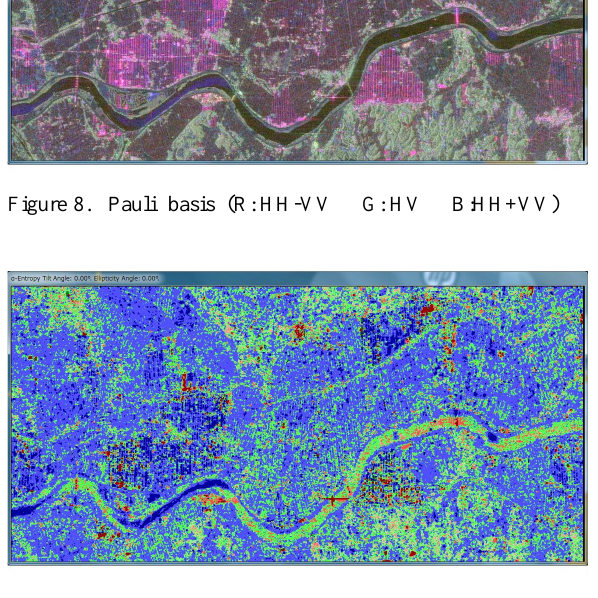
Figure 9. α , Entropy decomposition